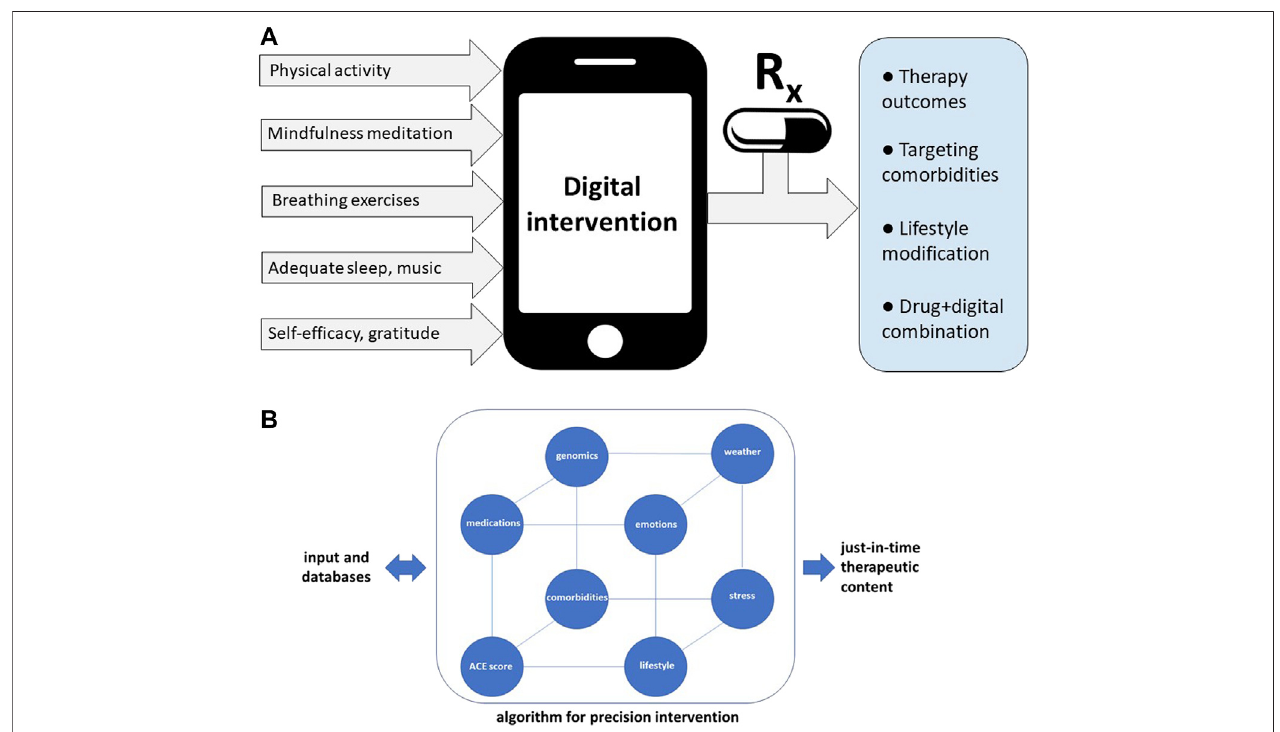
FIGURE 1 | Precision metapharmacology integrates pharmacotherapies with personalized, non-pharmacological interventions for chronic medical conditions including neurological, cardiovascular, metabolic, neurodegenerative, pulmonary, infectious diseases, mental disorders, and cancer. (A) Examples of diverse self-care practices delivered by digital health technologies aiming to improve therapy outcomes and lifestyle modi fi cations. Such digital interventions can be offered via digital health ecosystems (Shegog et al., 2020), or combined with pharmacotherapies (drug+digital combination therapies) (Sverdlov et al., 2018). Integration of digital therapeutics (mobile medical apps) with prescription medications is enabled using the regulatory pathway for drug-device combination products (in this case medical device isamobilemedical app, “ software asmedicaldevice ” )(Bulaj,2014).Expectedoutcomes ofprecisionmetapharmacology alsoincludepatientempowerment. (B) Examples of diverse factors included in algorithms optimizing delivery of just-in-time digital therapy content. For patients with higher adverse childhood experiences (ACE) scores or genetic risks for comorbidities, digital intervention can include cognitive behavioral therapy (CBT) combined with self-care practices which can mitigate risks for depression or anxiety. Optimization of digital content may include traumatic circumstances related to personal life, emotional state, or extreme atmospheric conditions.